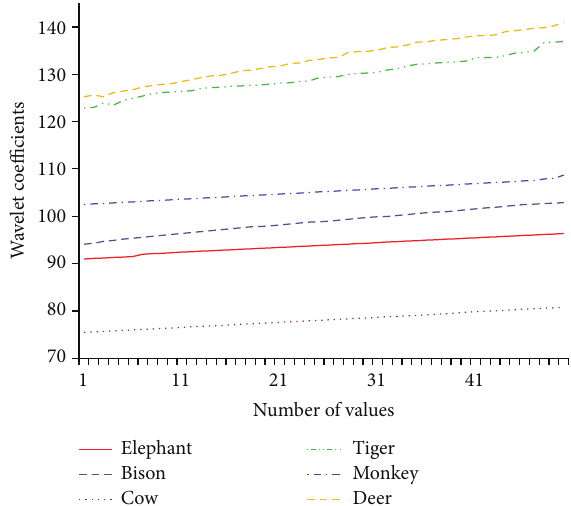
Figure 7: Wavelet Coefficients for Different Species.